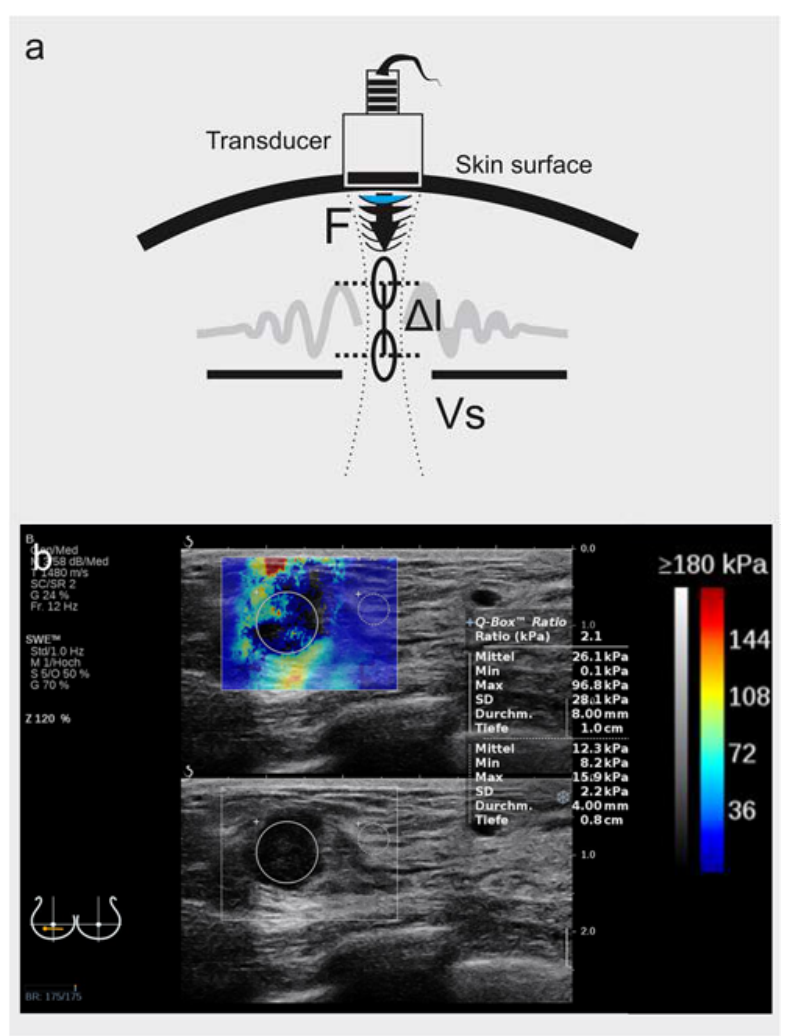
Figure 1. ( a ) Principles of shear-wave elastography. Shear-wave elastography (SWE) measures tissue density or stiffness in kPa through the mechanical distortion caused by an ultrasound wave. The transducer emits a perpendicular acoustic radiation force impulse (F), which causes a focal radial dislocation ( ∆ l) and initiates a transverse wave, known as a shear wave. The propagation speed of the shear wave (Vs) is measured by a detection pulse emitted by the same transducer. The tissue density ( ρ ) is inversely proportional to the shear wave propagation speed square ( ρ ~ 1/Vs 2 ). ( b ) Sample image SWE (SuperSonic Imagine). The tissue stiffness of each pixel is measured in kPa and is color-coded in a spectrogram (“elastogram“) which is overlaid to the B-mode image in real time and can be projected in dual-mode to the B-mode image. As a manufacturer’s standard, high stiffness is warm-colored (red), and elastic tissue with low kPa values is cool-colored (blue). In contrast to qualitative metrics for strain elastography, known as the 5 ‐ tier Tsu ‐ kuba–Ueno scale [20], SWE allows for a clear parametric readout of tissue stiffness in kPa. To effectively join function with anatomy, manufacturers project the kPa color ‐ adjusted heatmap over the B ‐ mode image to create a user ‐ friendly joint image called an “elasto ‐ gram” (Figure 1b). The SWE interface supports the custom definition of regions of interest (ROI) and calculates the average and maximum stiffness as characteristic tumor parame ‐ ters (Figures 1b and 2a). It is, however, a user´s interpretation as to whether the ROI en ‐ compasses or partially segments the tumor margins in B ‐ mode. Hence, despite the clear